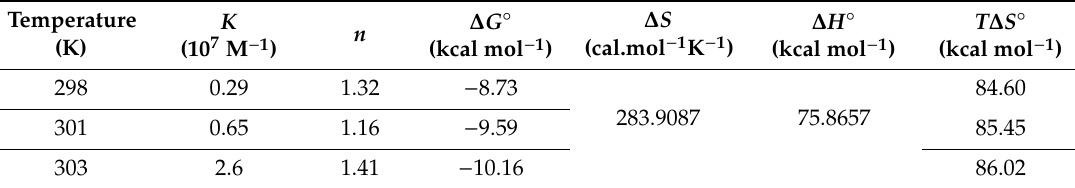
Table 2. Thermodynamic parameters of CDK6-EA